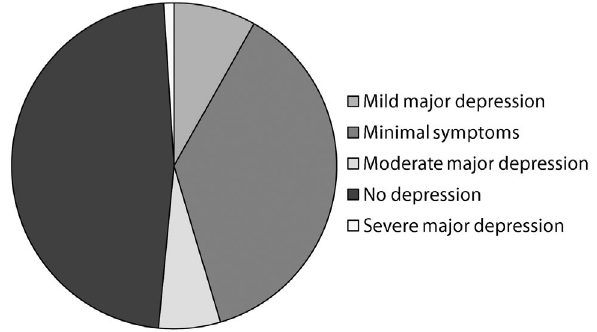
Table 1: Socio-demographic characteristics of the married women